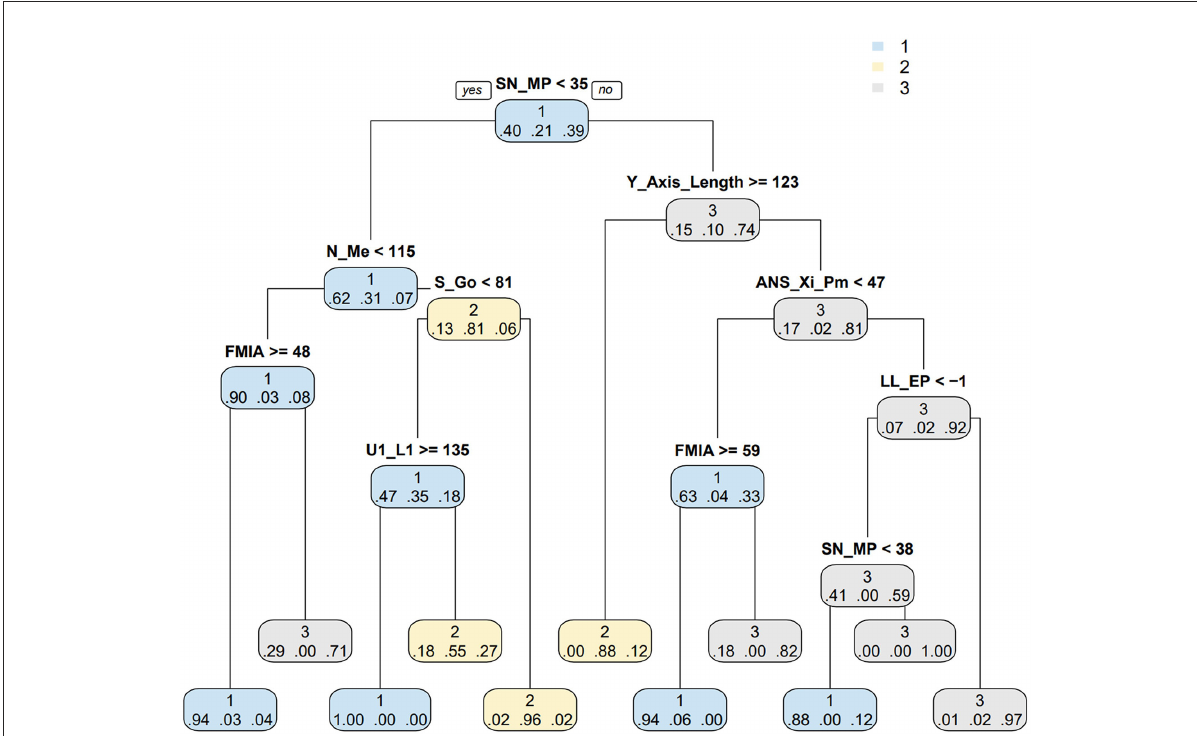
FIGURE10 CART model for predicting cephalometric data category. The left branch of the binomial tree indicates the cases that meet the conditions while the right branch do not. The decimal below the branch indicates the probability that the sample belongs to cluster 1, 2, or 3 at this time. CART: classification and regression